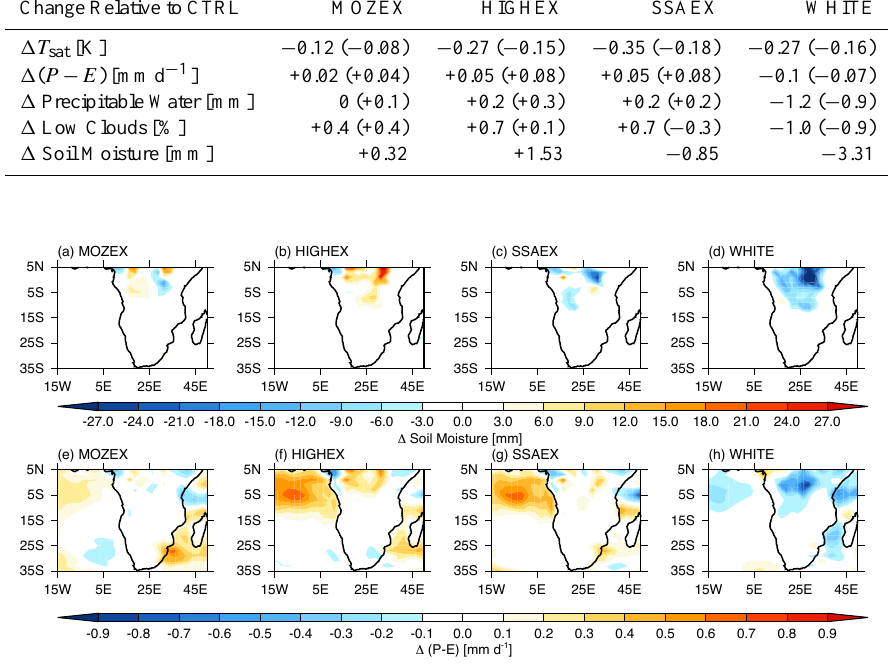
Fig. 7. ASO soil moisture change relative to CTRL ( 1 Soil Moisture; [mm]) for (a) MOZEX, (b) HIGHEX, (c) SSAEX, and (d) WHITE. ASO change in precipitation minus evaporation ( 1 (P-E); mmd − 1 ) relative to CTRL for (e) MOZEX, (f) HIGHEX, (g) SSAEX, and (h)